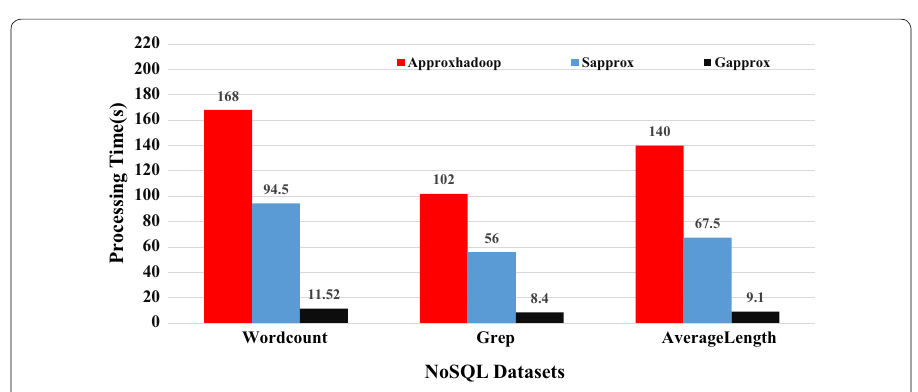
Fig. 13 Processing time for sampling (NoSQL